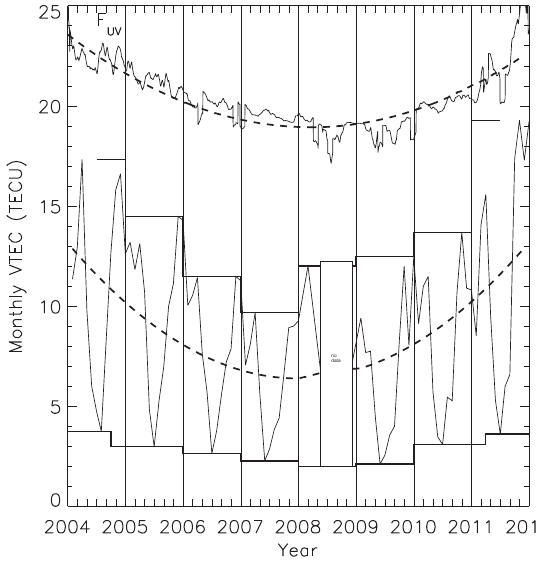
Figure 2. Variation of the 31-day smoothed solar He II radiation (30.4 nm, F ) (top) and the monthly averaged daily maximum UV VTEC (lower curve) from 2004 to 2011. The yearly maximum and minimum VTEC values are also shown. Both datasets were fitted using cubic polynomial regression (dashed